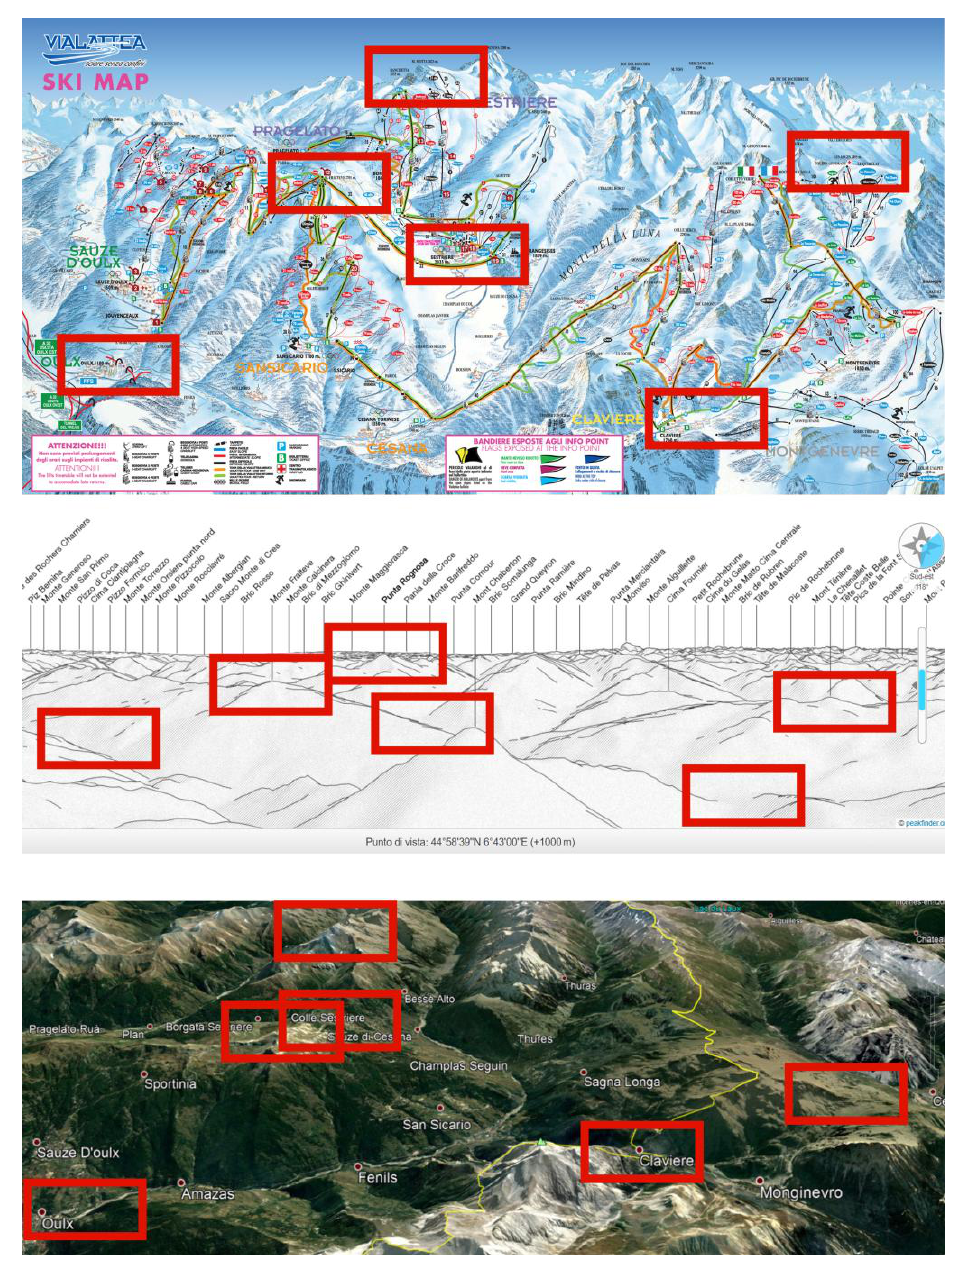
Figure 5. Example of the deformation of terrain and mountain features in the production on a panoramic ski map in the case of the ski resort “Via Lattea” between Italy and France. The graphical elaboration show the relative position of some sites in three images; from the up: the ski map [34], a panorama created with PeakFinder [19], a view from Google Earth. The comparison between the ski map and the other two cartographic views shows the presence of strong local deformations of terrain in the ski